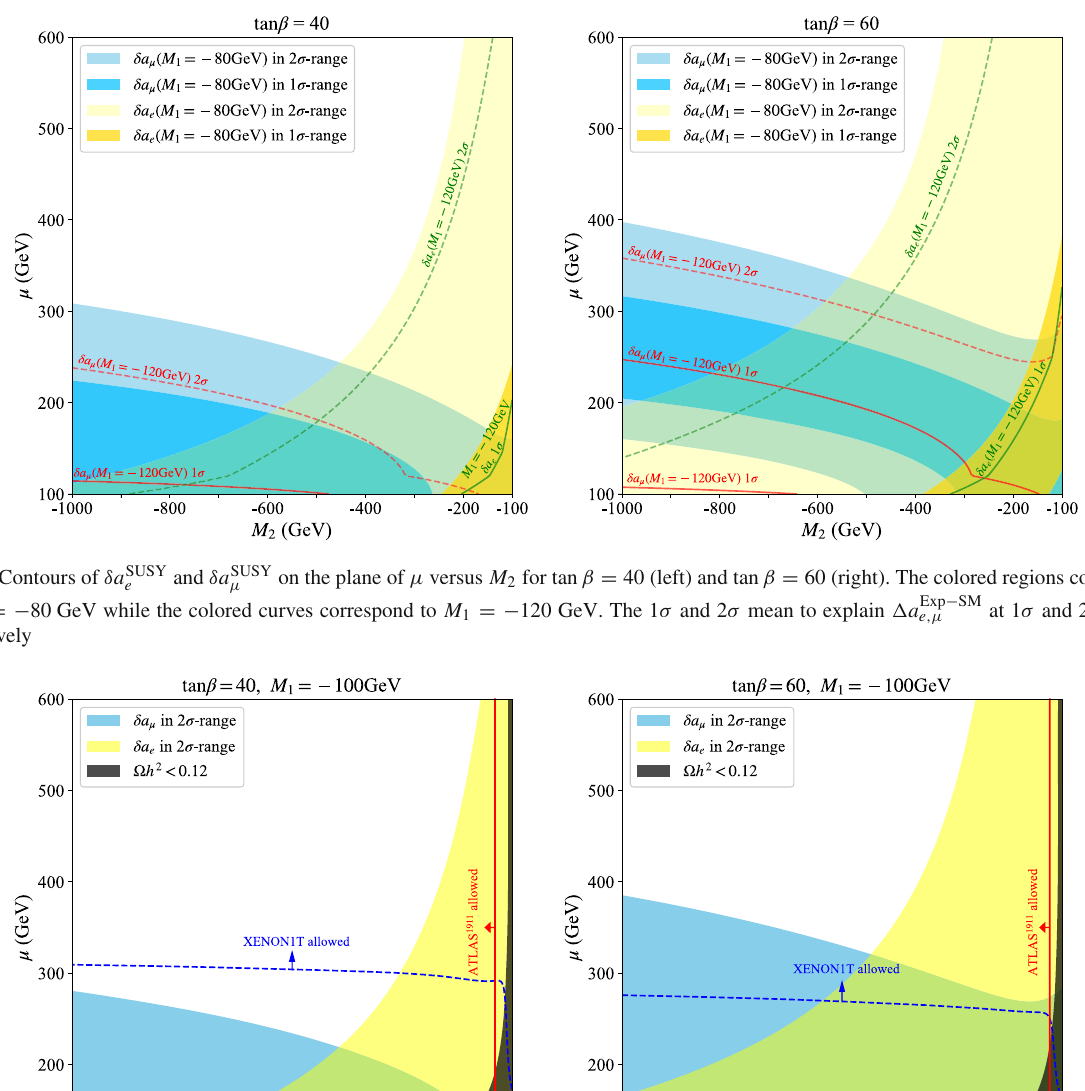
Fig. 2 The parameter regions survived the dark matter relic density constraint and the XENON1T exclusion limits on the plane of μ versus M 2 with M 1 = − 100 GeV and tan β = 40 , 60. The 2 σ regions for